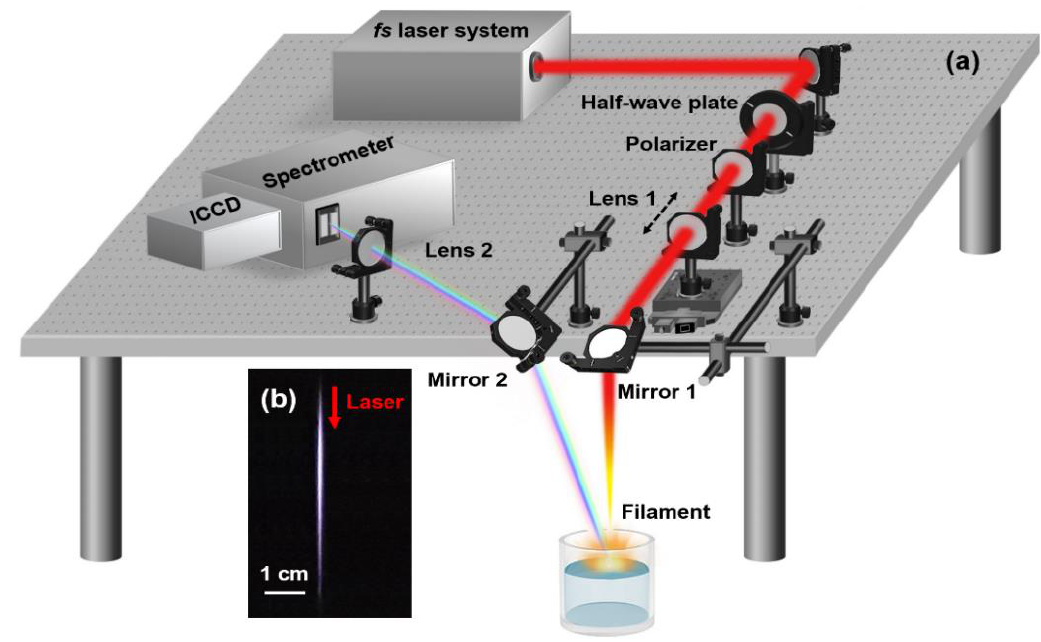
Figure 1. ( a ) Schematic diagram of experimental setup; ( b ) the filament image captured with a digital camera; the red arrow indicates the laser propagation direction.